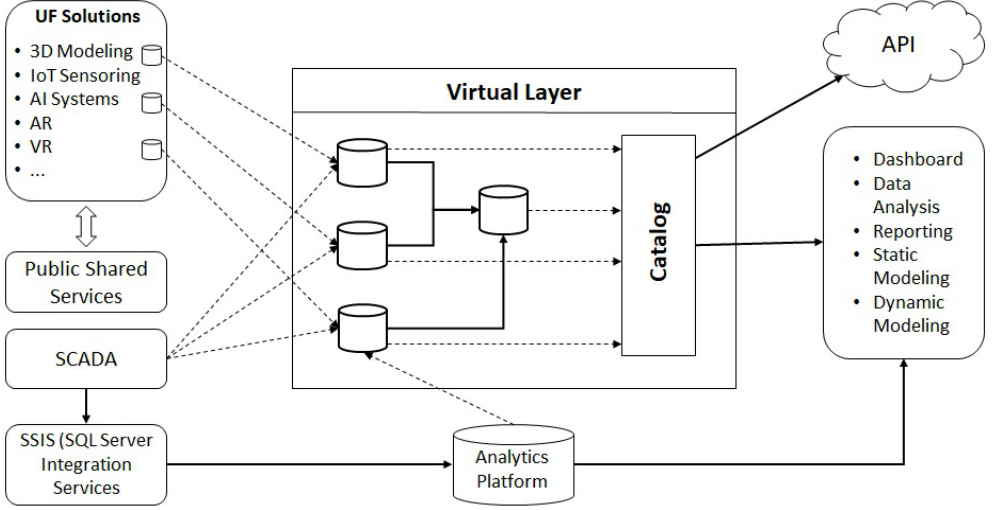
Figure 8. Thermographic image analysis